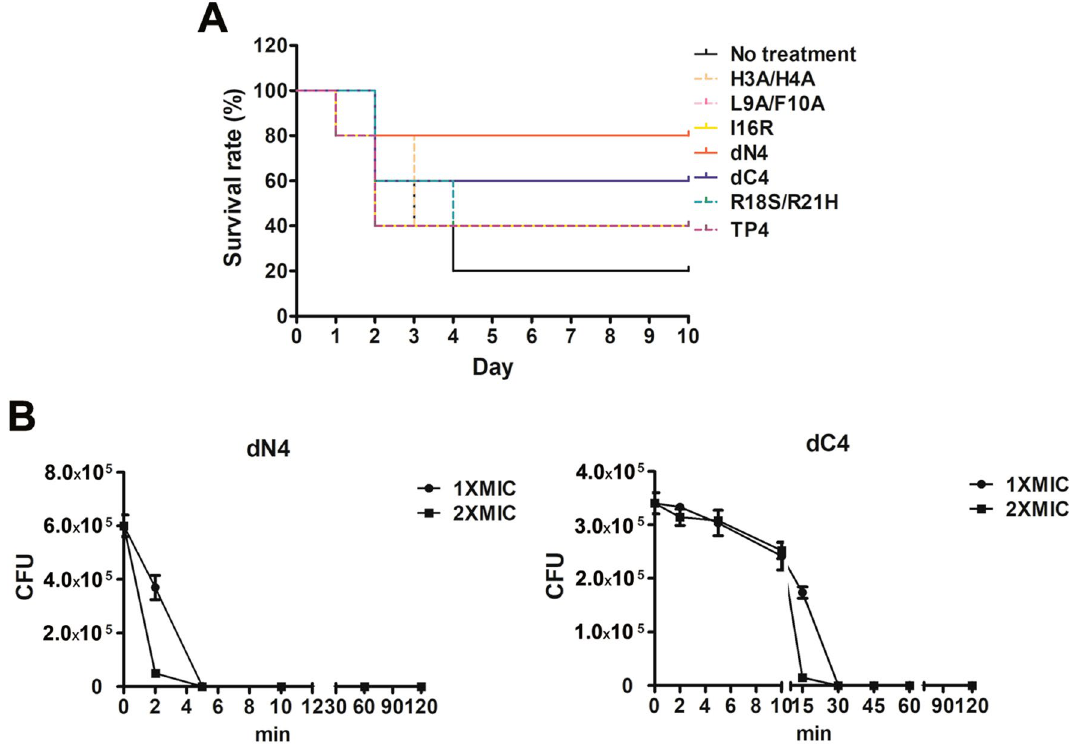
Figure 2. Peritoneal administration of TP4 derivatives in A. baumannii -induced pneumonia mouse models. ( A ) Mice were intratracheally infected with A. baumannii ATCC 17,978 at a dose of 5 × 10 8 CFU. TP4 derivatives (2 mg/kg) were peritoneally administrated 4 h after bacterial infection, and mouse survival was detected daily ( n = 5/group). ( B ) A. baumannii ATCC 17,978 (2–5 × 10 5 CFU) were mixed with 1 × and 2 × MIC of dN4 (32 and 64 μg/mL) or dC4 (32 and 64 μg/mL), and incubated at 37 °C. The survival bacteria were detected by plating on agar